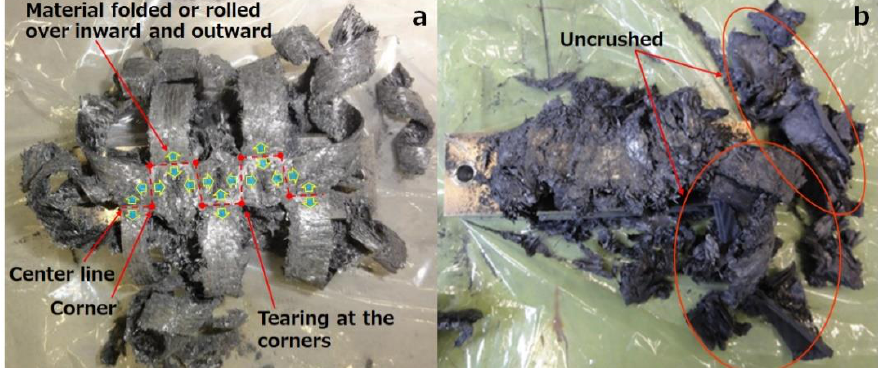
Figure 15. Comparison of specimen after compression test. ( a ) Progressive crushing, case: 12ply-P15; ( b ) nonprogressive crushing, case: 16ply-P5.